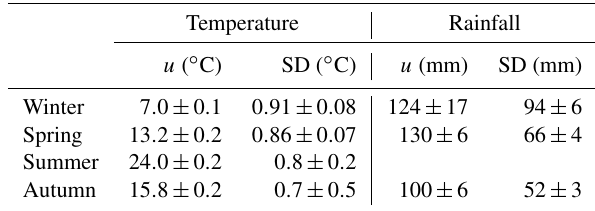
Table 4. Reconstruction of the period 1706–1730 in Granada. u : mean value; SD: standard